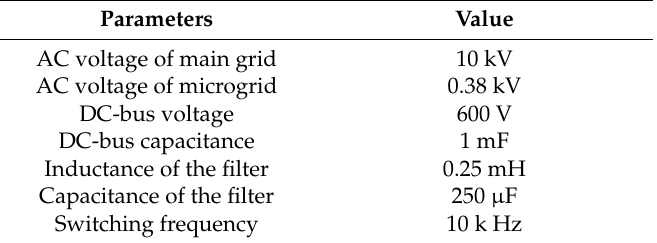
Table 4. Simulation parameters.